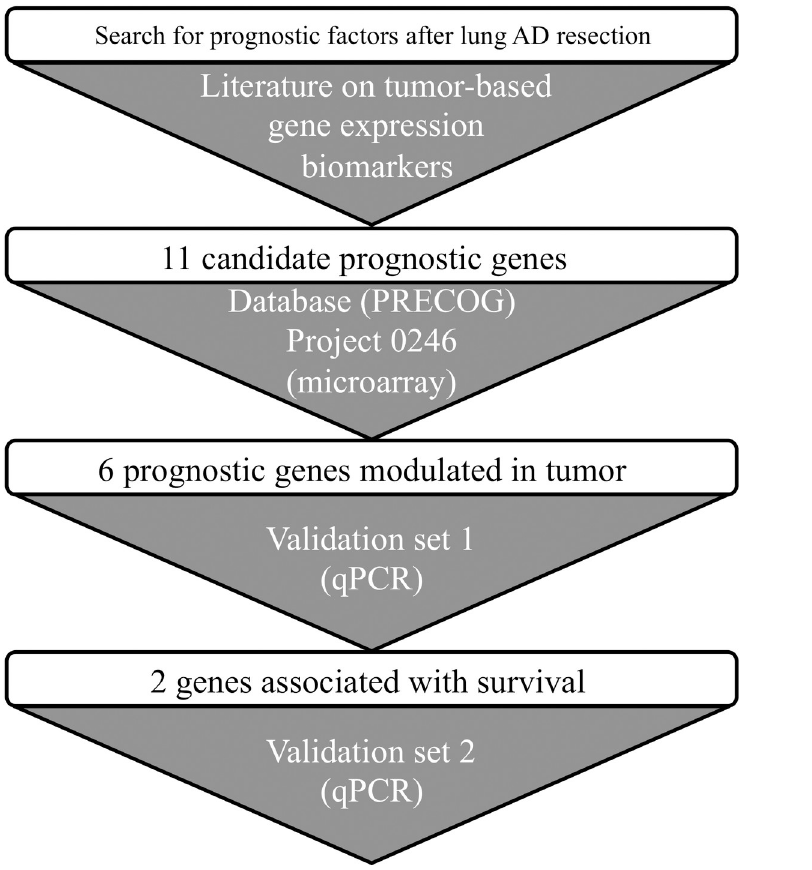
Fig 1. Flowchart for gene expression biomarkers selection, filters, and analysis.